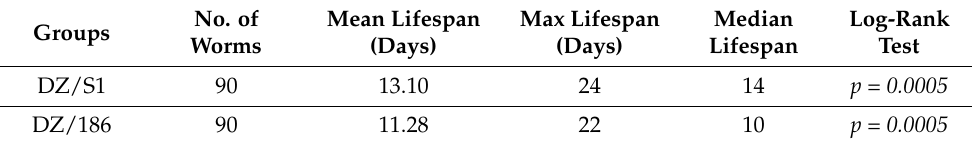
Table 2. The lifespan of H. chongmingensis (DZ) worms cultured in NGM liquid medium with cognate bacterial strain S. nematodiphila S1 and non-cognate bacterial strain S. nematodiphila 186. No. of Mean Lifespan Max Lifespan Median Log-Rank Groups Worms (Days) (Days) Lifespan Test DZ/S1 90 13.10 24 14 p = 0.0005 DZ/186 90 11.28 22 10 p =